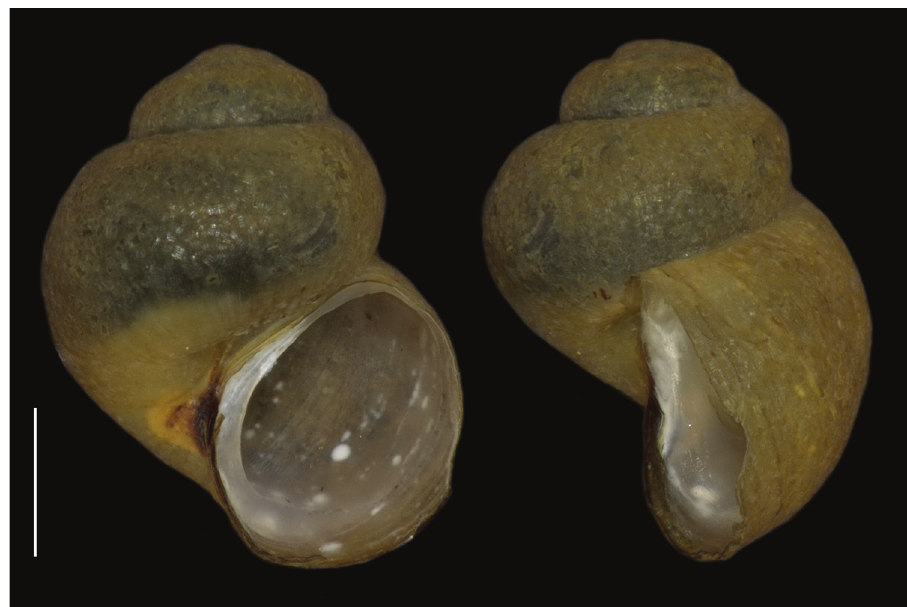
Figure 1. Erhaia wangchuki sp. n., sequenced paratype; scale bar 0.5 mm (photographs by B.S.); Bhutan,